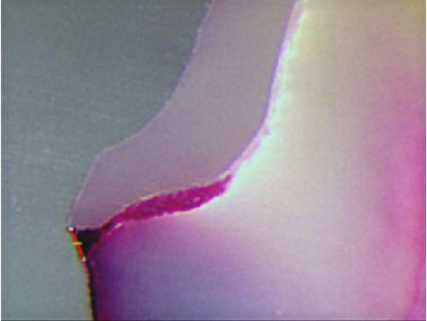
Figure 1: AMD image obtained (magnification lens 20x).